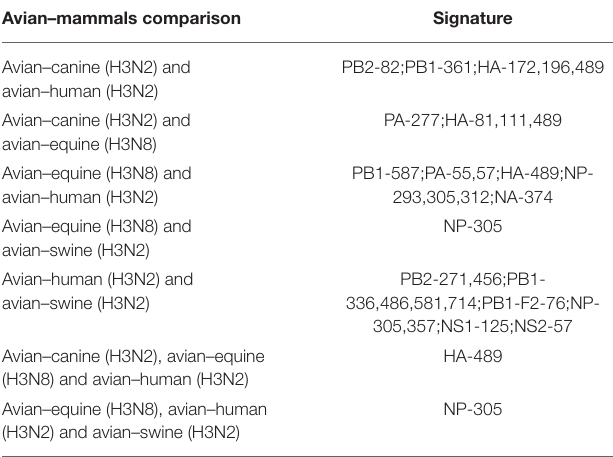
TABLE 3 | Common signatures in different avian–mammal calculation results of H3 IAVs. Avian–mammals